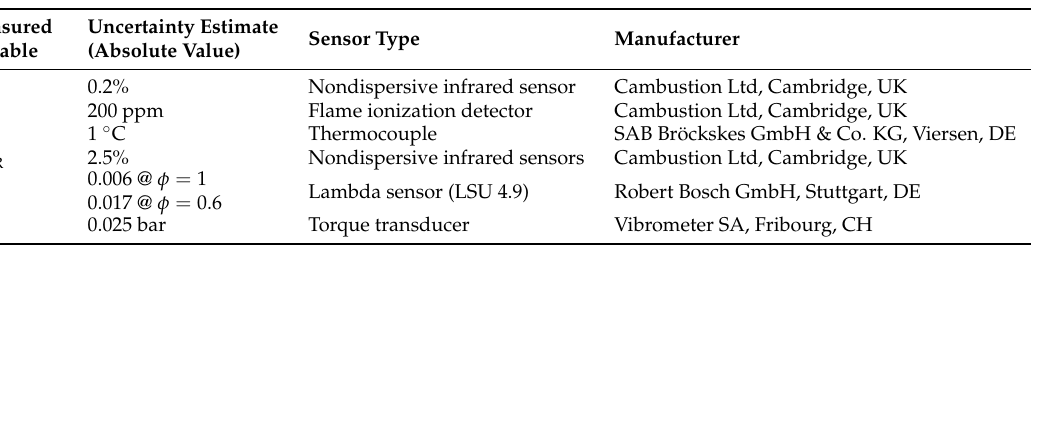
Table A4. Measurement